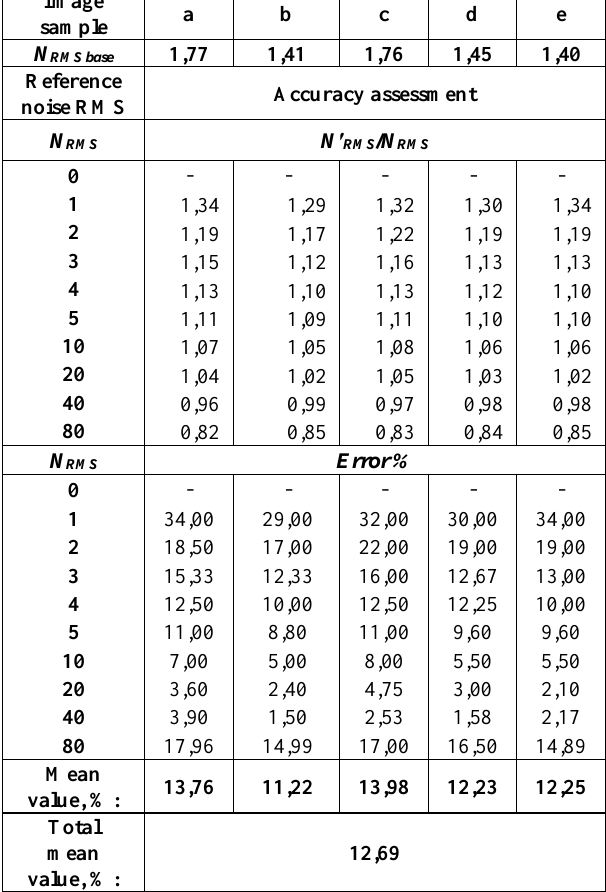
Table 3. The algorithm’s based on harmonic analysis accuracy evaluation